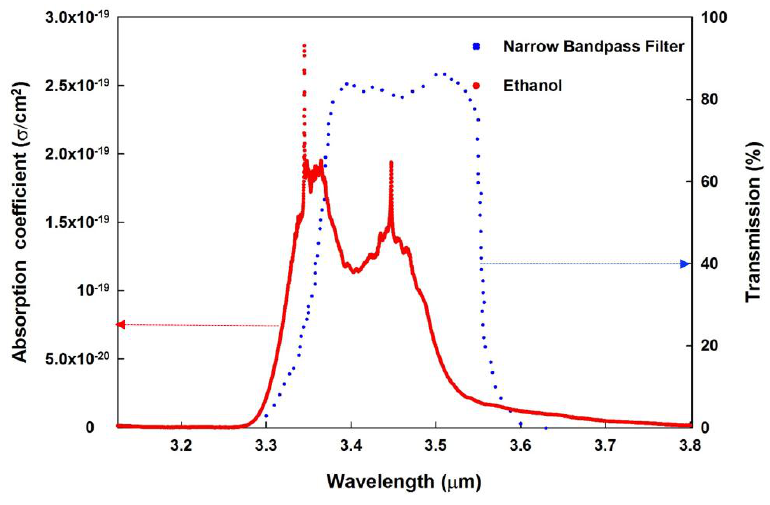
Figure 1. Superimposed transmission spectrum of the narrow band-pass filter on the absorption spectrum of ethanol gas.